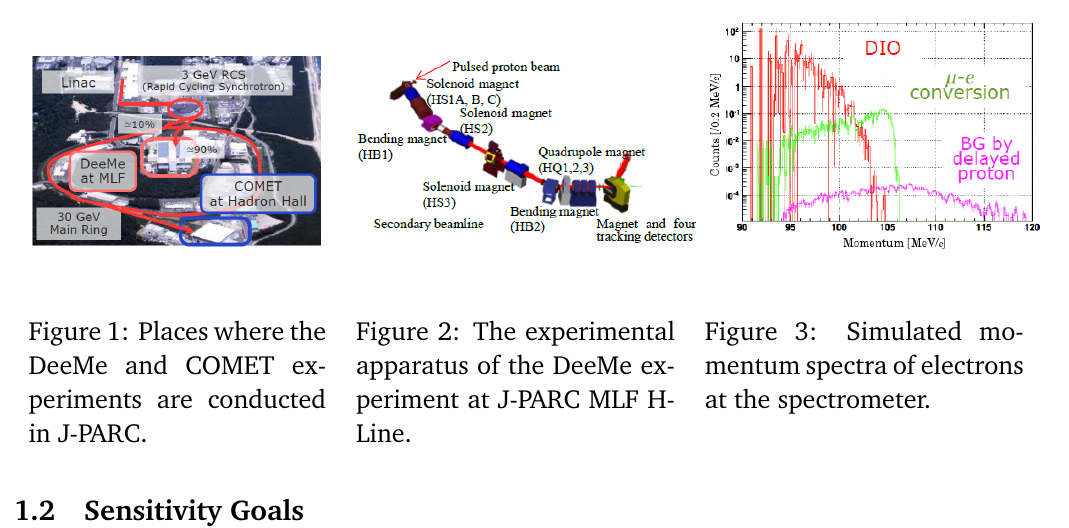
Figure 1: Places where the DeeMe and COMET ex- periments are conducted in J-PARC.